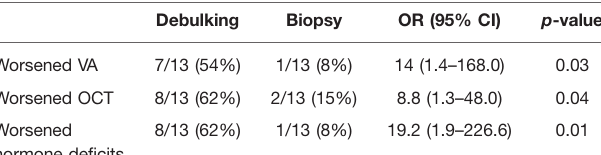
TABLE 4 | Correlation of VA, OCT and hormonal de fi cits according to different surgical approach (biopsy vs